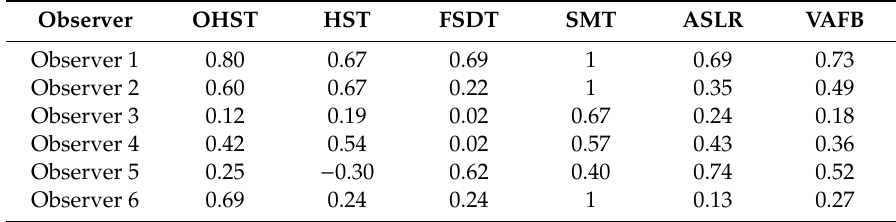
Table 9. Intra-observer reliability, Kappa